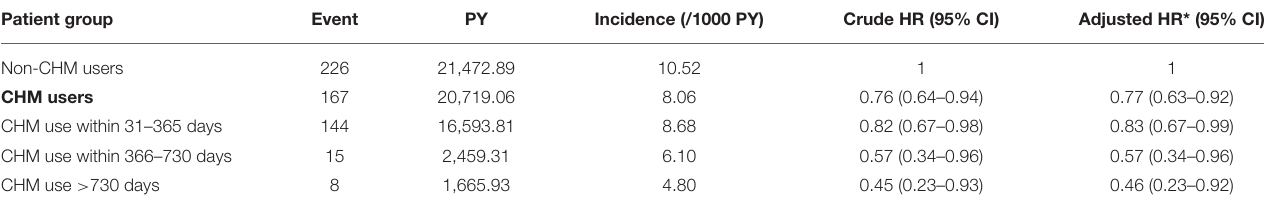
TABLE 2 | Risk of HL for RA patients with and without CHM use.